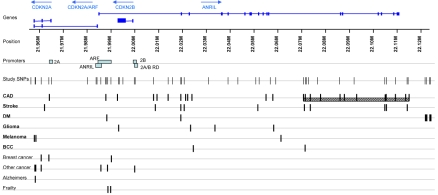
SNPs associated with disease in the chromosome 9p21.3 region.Genes are illustrated in blue at the top, with arrows representing the direction of transcription. SNPs typed in our study and SNPs associated with various diseases are represented by black bars. Diseases in bold are those with association data from genomewide association studies. The hatched box represents the core risk haplotype for CAD defined by Broadbent et al
[35]. Promoter regions for each gene are shown as pale blue boxes. DM = diabetes mellitus type II; BCC = basal cell carcinoma.